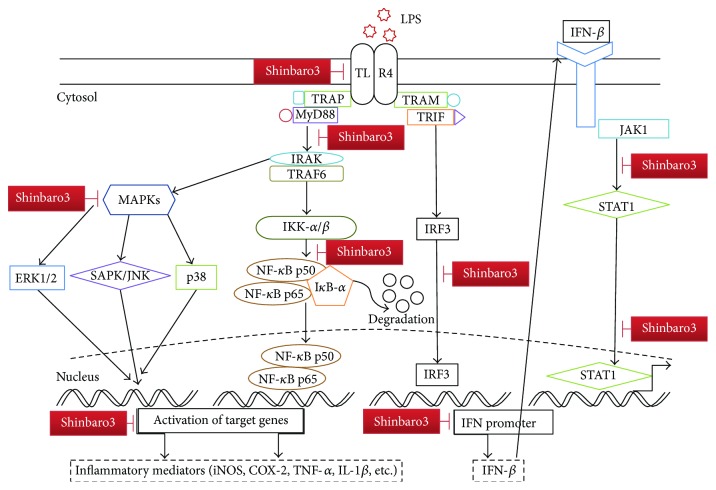
Overview of the TLR4 signalling pathway. The mechanisms underlying the inhibitory effects of Shinbaro3 on the LPS-induced inflammatory response.